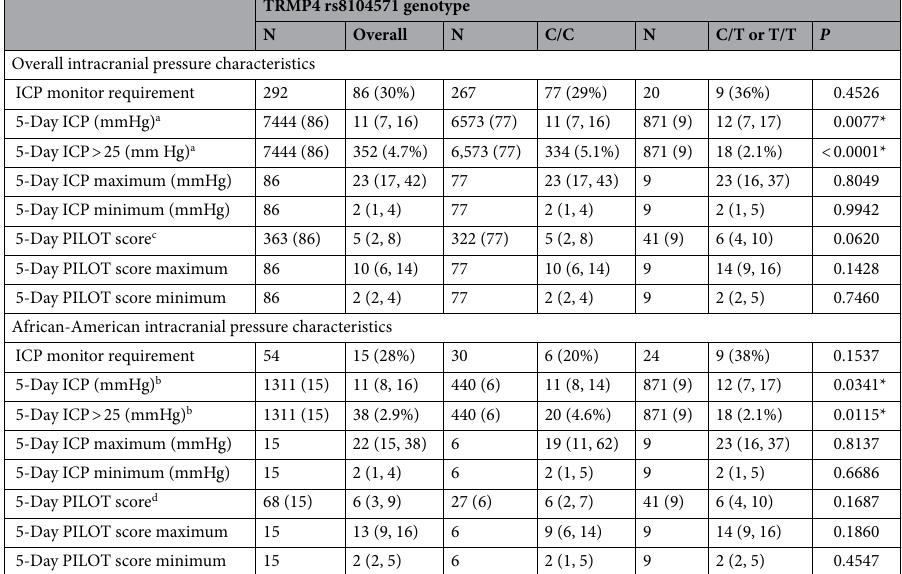
Table 4. Intracranial pressure characteristics stratified by TRMP4 rs8104571 genotype distribution for the overall study population and African Americans denoted as median (IQR) or number of observations (%). C cytosine, T thymine, ICP Intracranial pressure, recorded within 5 days of admission; a N: ICP measurements (participants), Overall study population: 7444 total ICP measurements (C/C: 6573; C/T: 803; T/T: 68); b N: ICP measurements (participants), African-American study population: 1,311 total ICP measurements (C/C: 440; C/T: 803; T/T: 68); PILOT: Pediatric intensity level of therapy scale, within 5 days of admission; c N: PILOT scores (participants), Overall study population: 363 total PILOT scores (C/C: 322, C/T: 37, T/T: 4); d N: PILOT scores (participants), African-American study population: 68 total PILOT scores (C/C: 27, C/T: 37, T/T: 4); *Significant P values <